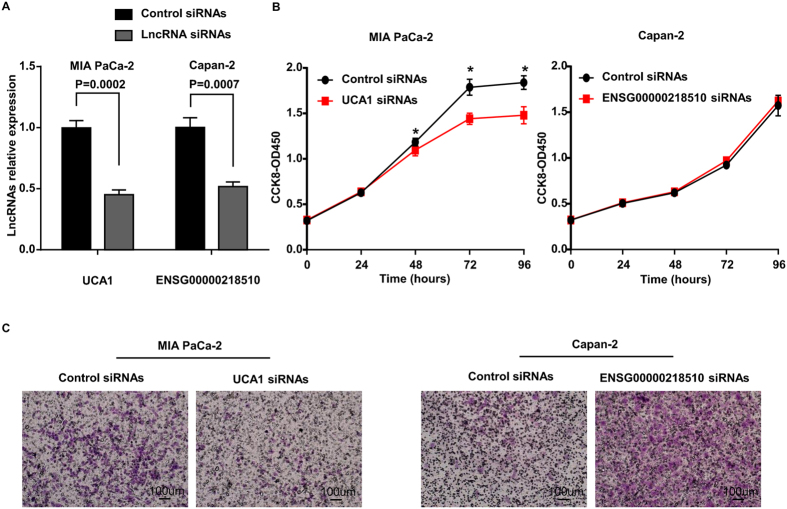
LncRNA UCA1 and ENSG00000218510 regulate the proliferation and/or invasion abililty of PDAC cell lines.(A) UCA1 and ENSG00000218510 knockdown efficiency was confirmed by qRT-PCR in MIA PaCa-2 and Capan-2 cell line, respectively. (B) The effect of UCA1 and ENSG00000218510 knockdown on PDAC cell line proliferation was determined by CCK-8 assays. *P < 0.05, Student’s t-test. Data are represented as the mean ± SD. (C) Representative images of transwell assay after UCA1 and ENSG00000218510 knockdown in MIA PaCa-2 and Capan-2, respectively.